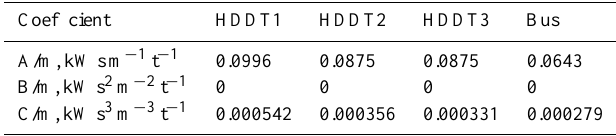
Table 3. Summary of road-load coefficient values for calculating VSP of each major HDDV